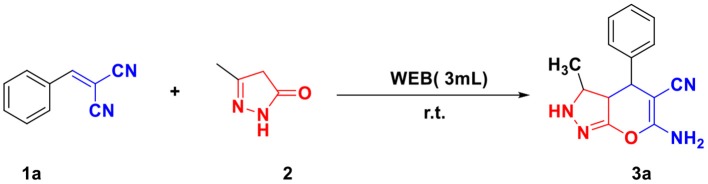
Scale-up experiment.